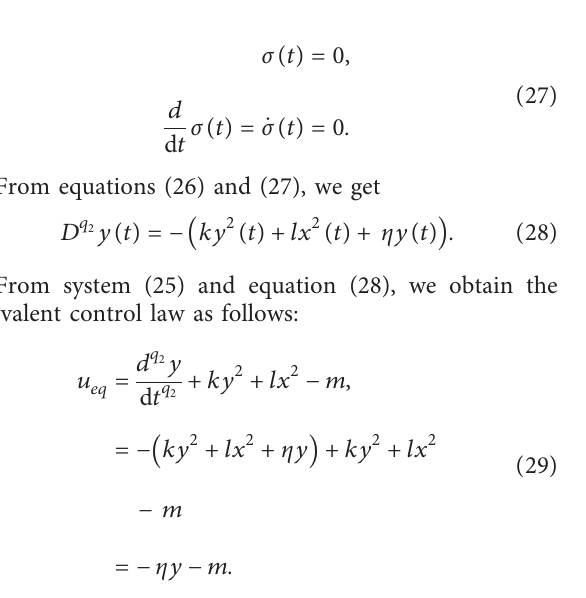
Figure 8: Bifurcation diagram and largest Lyapunov exponent ( λ Lyapunov exponent ( λ